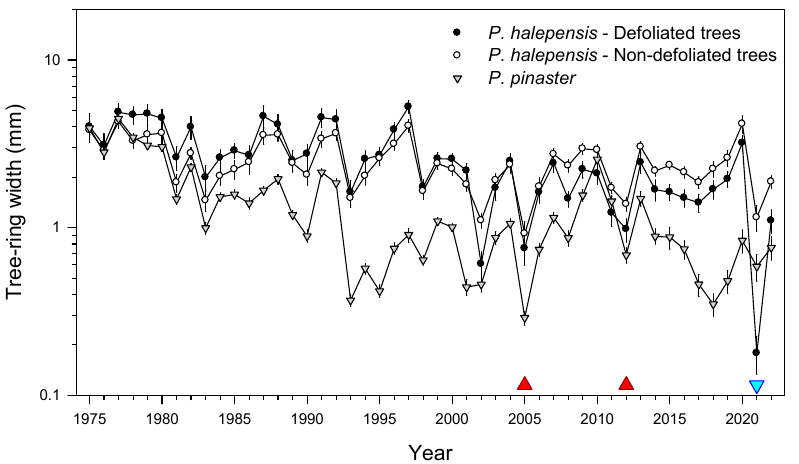
Figure 4. Growth patterns of defoliated and non-defoliated P. halepensis trees and coexisting P. pinaster trees. Note the logarithmic scale of tree-ring width data. The red-upward and blue-downward triangles indicate recent droughts (2005, 2012) and the 2021 cold spell, respectively. Values are means ± SE.